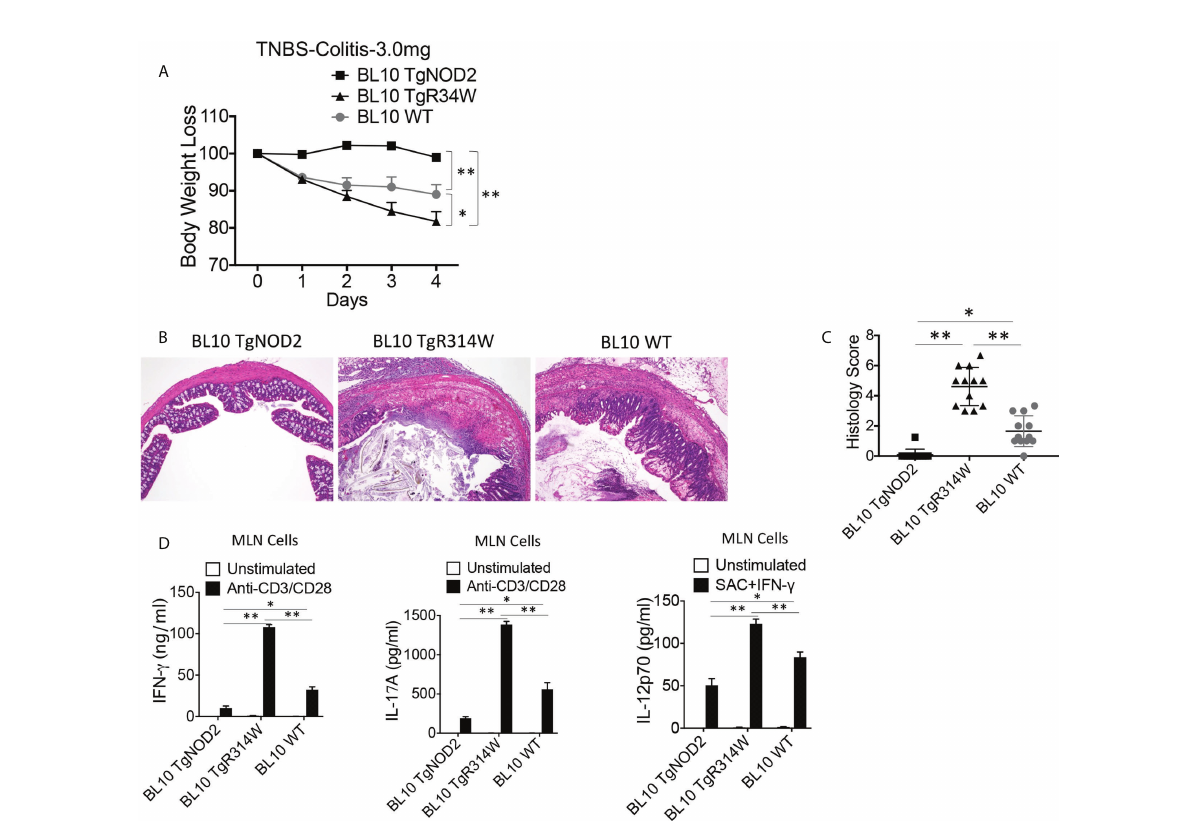
FIGURE 4 Transgenic BS-NOD2 Has a Dominant-Negative Effect which Interferes with the Cross-Regulatory Function of Endogenous NOD2 in TNBS- Colitis. (A) TNBS-colitis associated weight loss of C57BL/10 mice bearing transgenes expressing intact NOD2 (BL10 TgNOD2, n=6) or NOD2- R314W (BL10 TgR314W, n=8) and wildtype (BL10 WT, n=10) mice administered TNBS per rectum (3.0 mg/mouse); mice were harvested